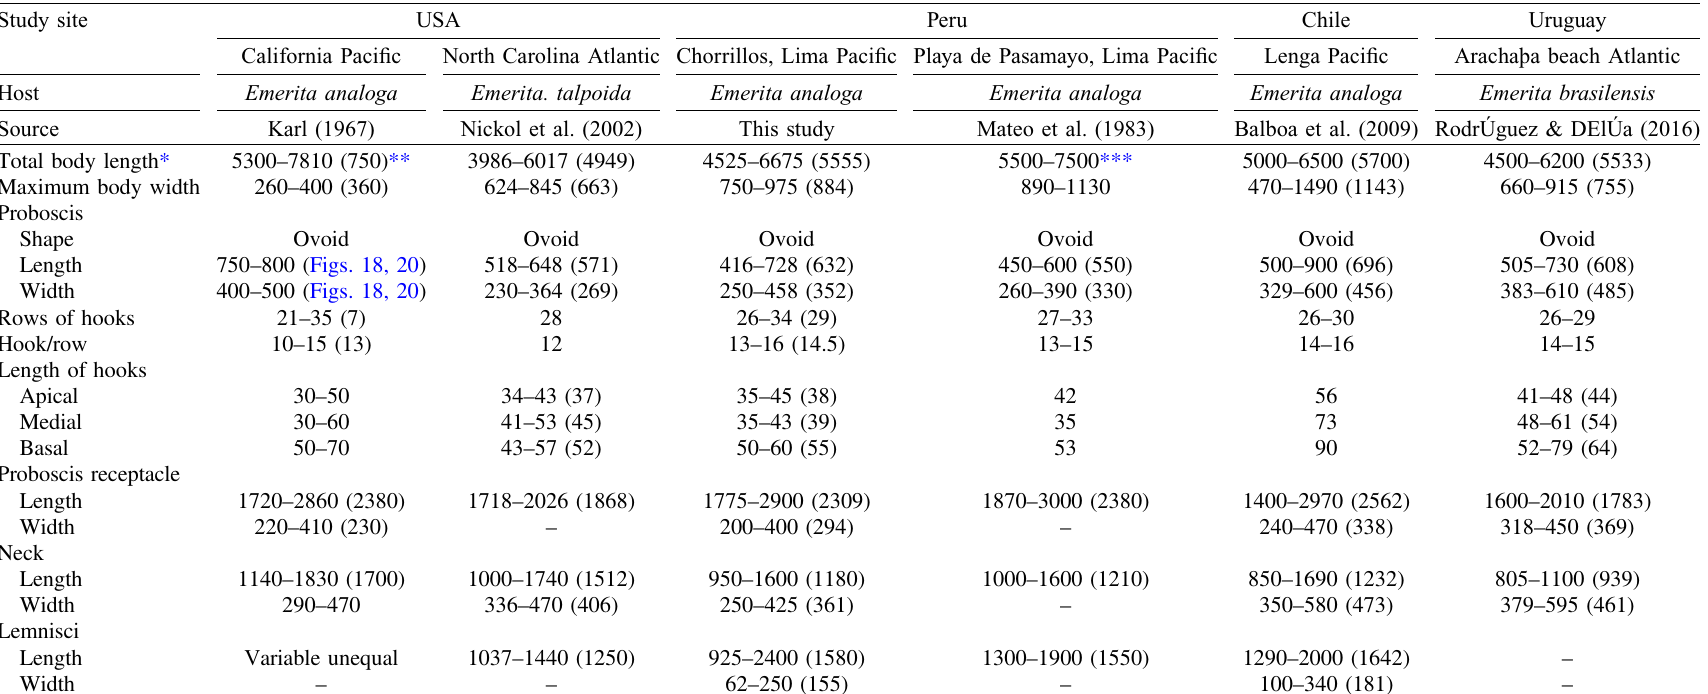
Table 1. Morphometrics of cystacanths of Pro fi licollis altmani from the USA, Peru, Chile, and